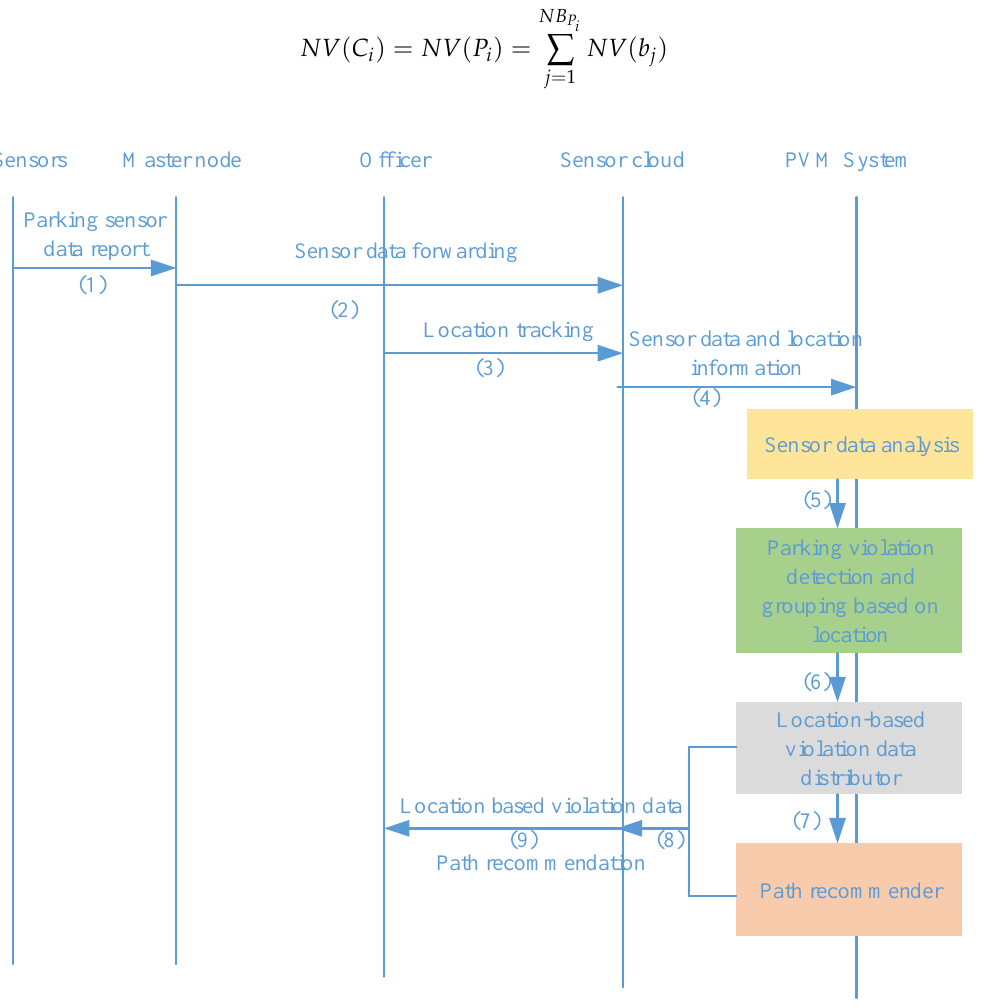
Figure 11. Processing flow of the